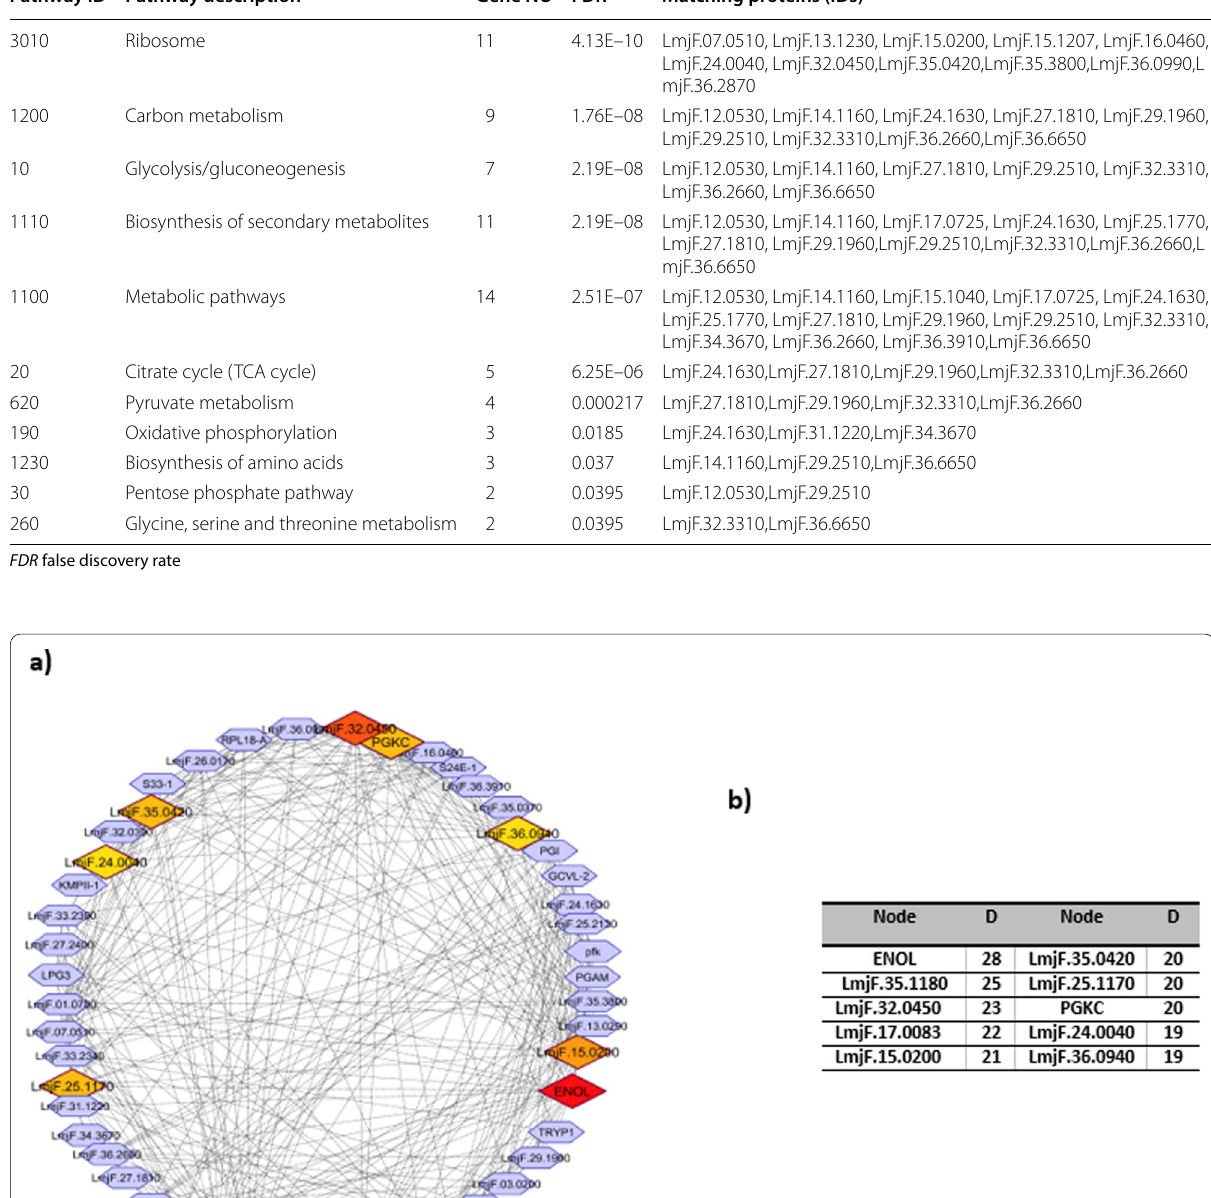
Table 3 The KEGG pathways of down‑regulated proteins during conversion of L. tropica metacyclic into the amastigote‑like Pathway ID Pathway description